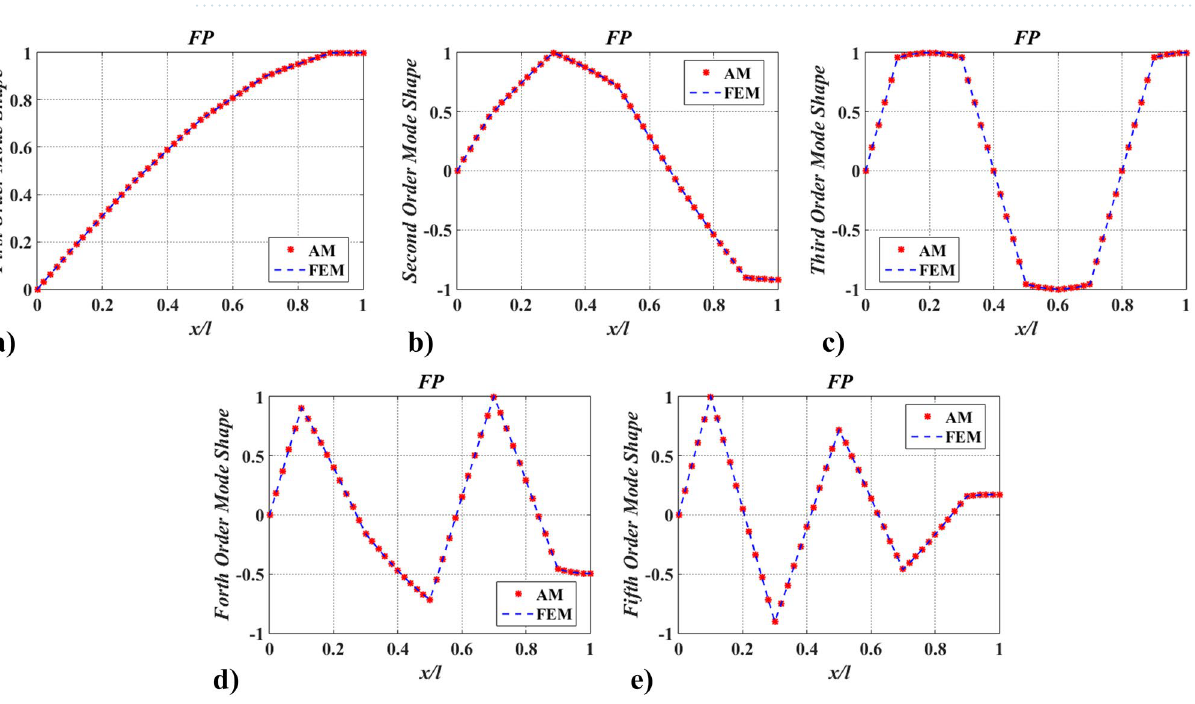
Figure 11. The lowest five mode shapes of twisting angles for the shaft carrying five concentrated elements in the FP support conditions obtained from FEM and AM (small number of discrete